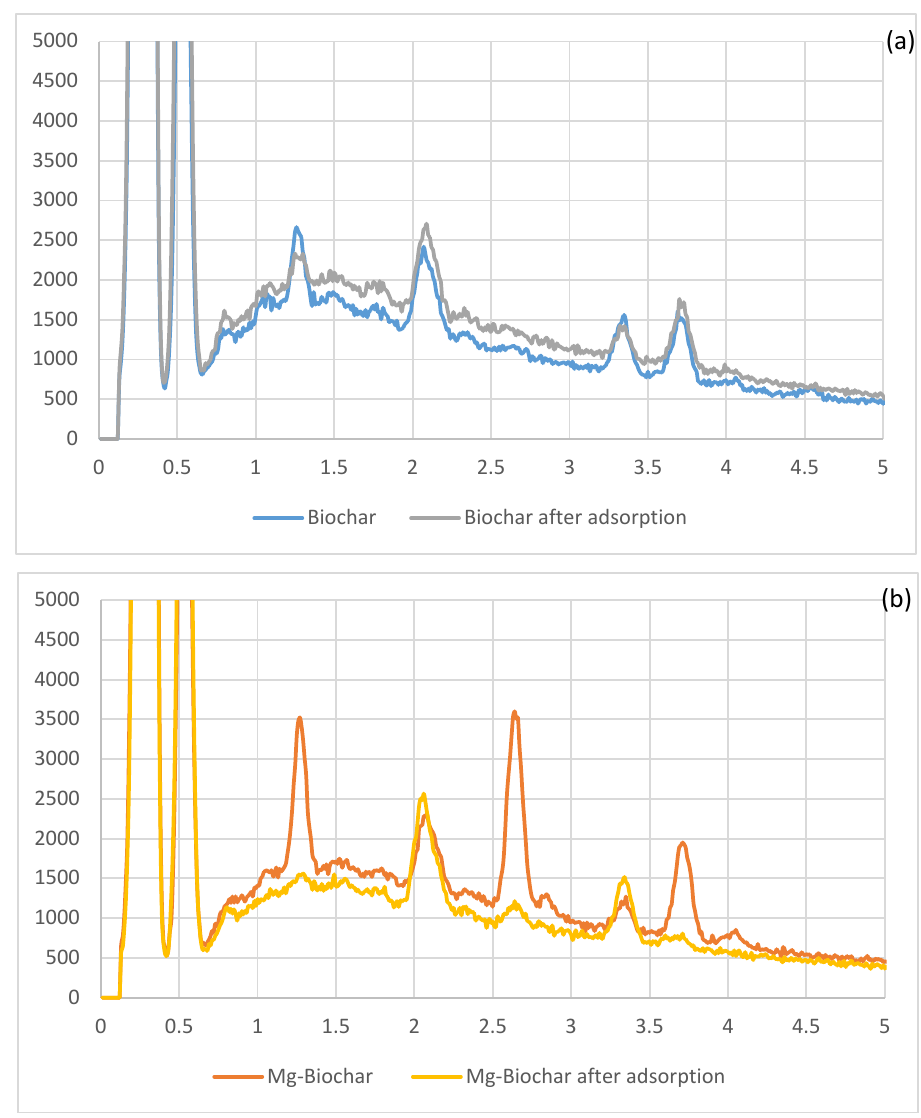
Figure 6. EDS scans before and after adsorption: (a) unmodified biochar; and (b) modified biochar